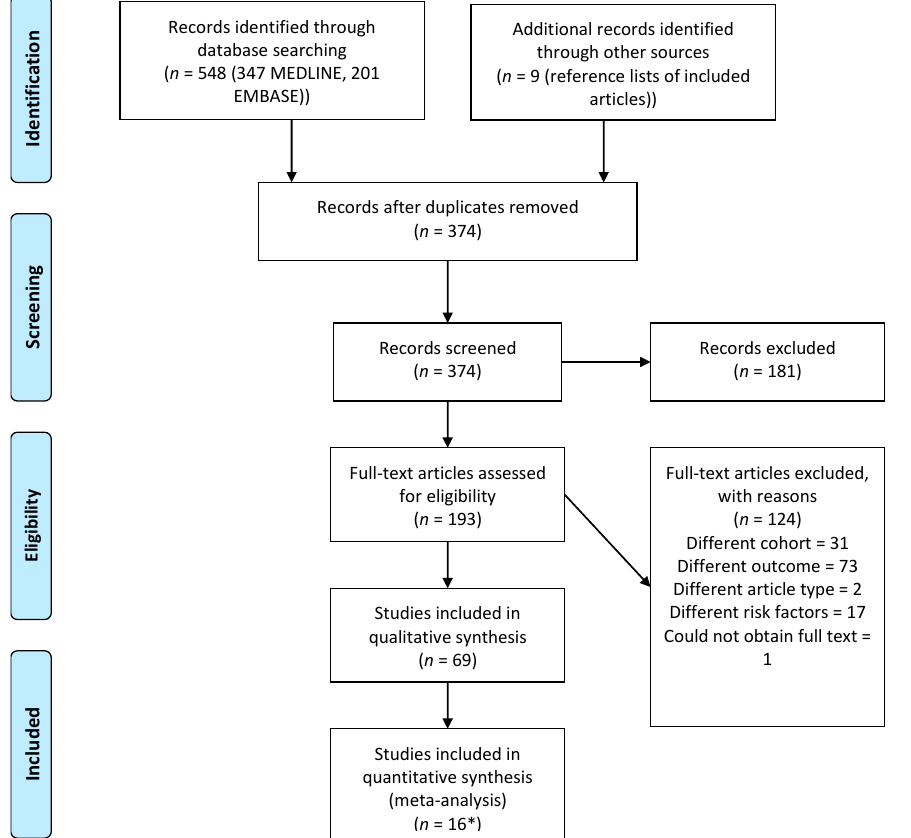
Figure 1. PRISMA Flow Diagram. PRISMA flow diagram depicting the number of articles screened and included in the review. * included in both meta-analysis and qualitative synthesis Table 3. Study characteristics.